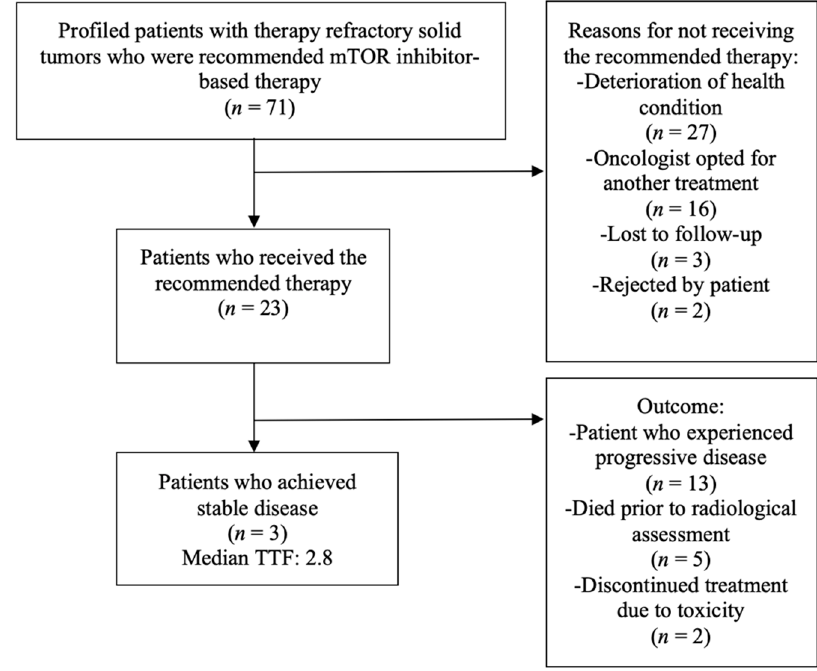
Figure 7. Flow chart of the 71 cancer patients.